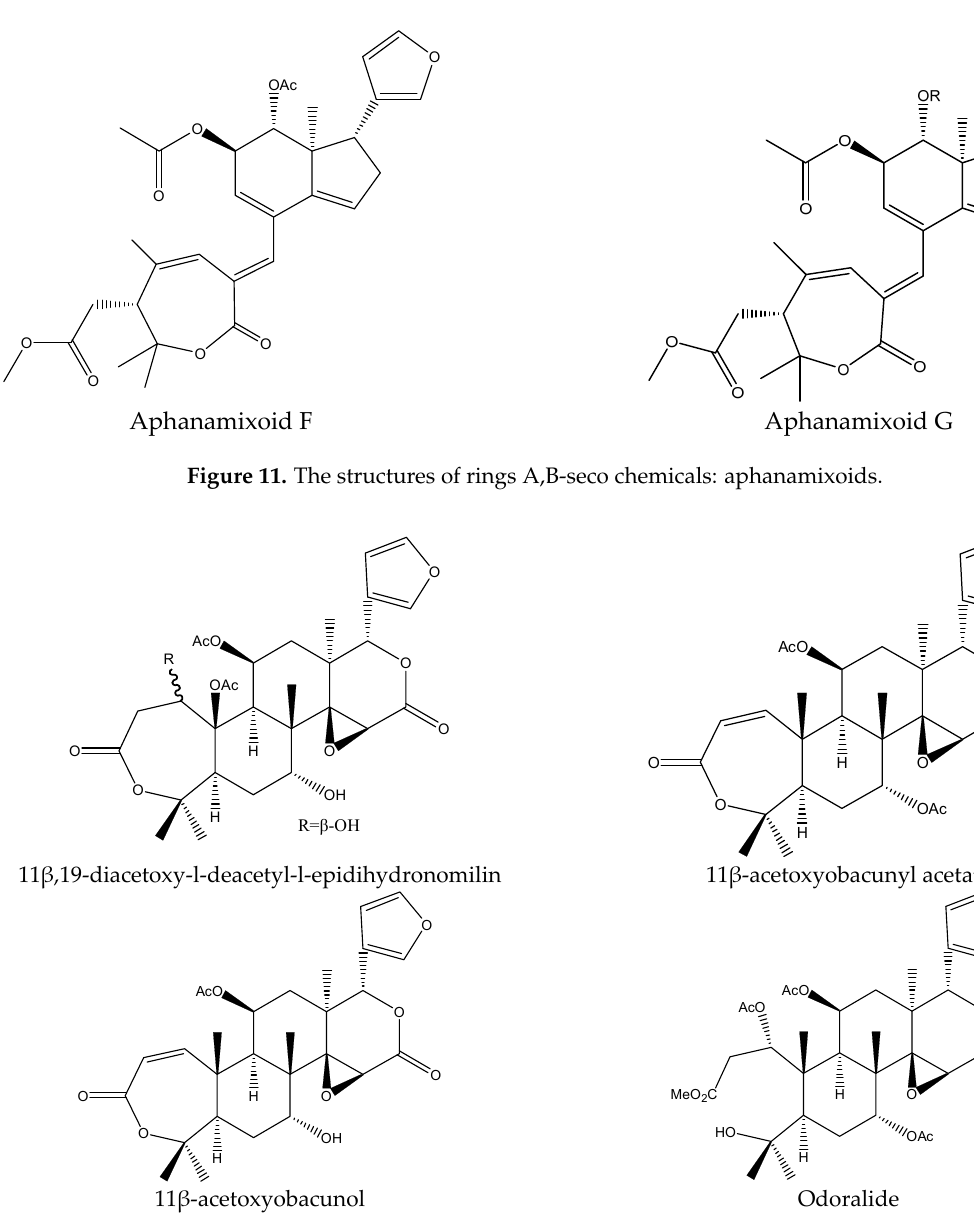
Figure 12. The structures of A,D-seco chemicals.